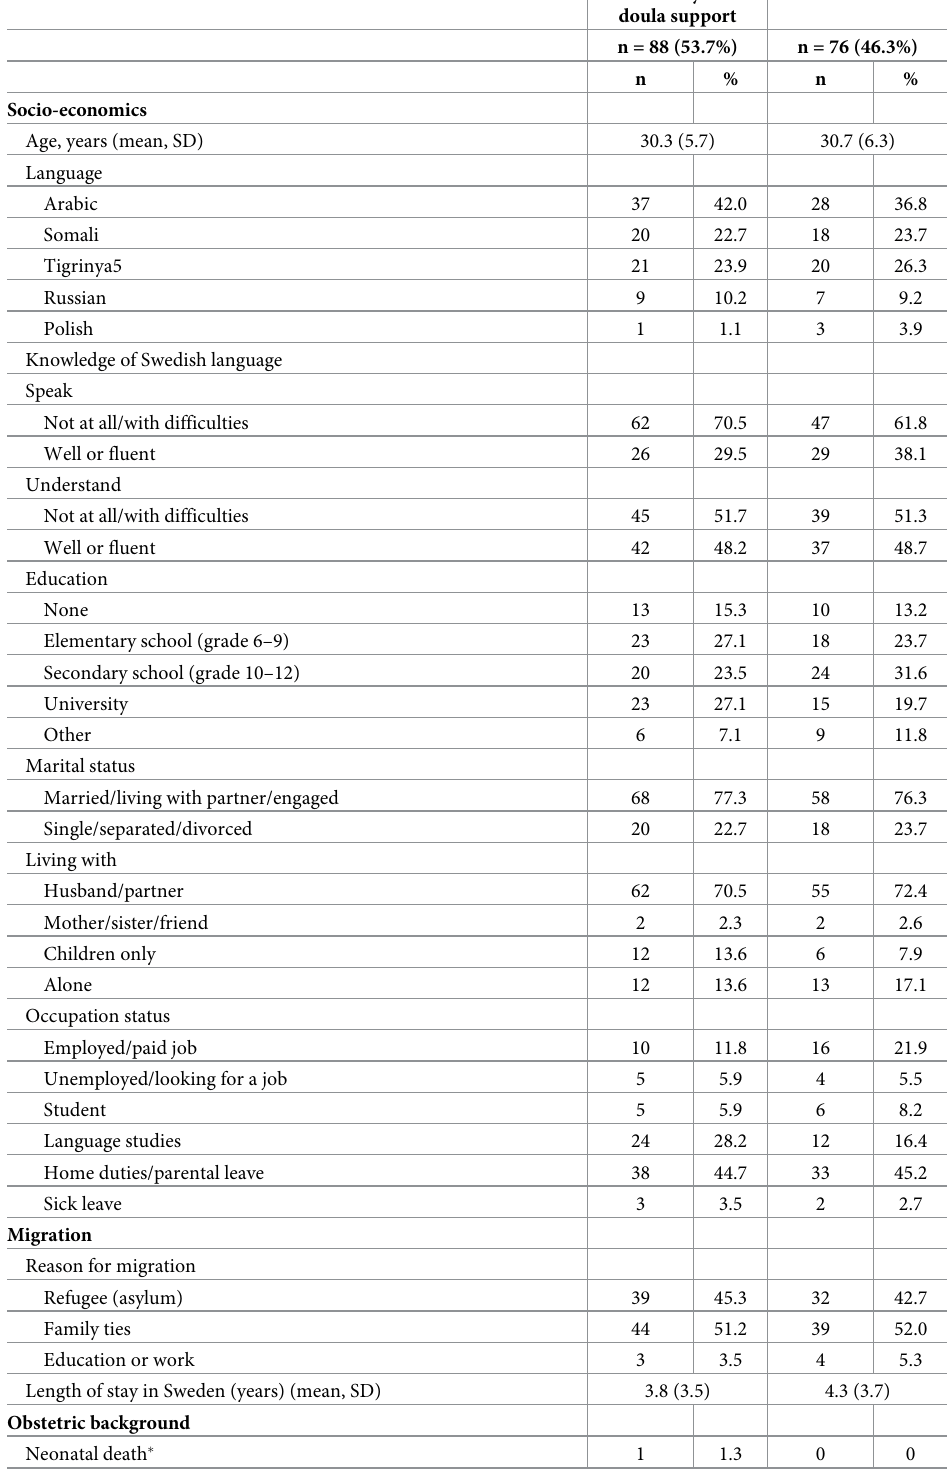
Community-based Standard doula support